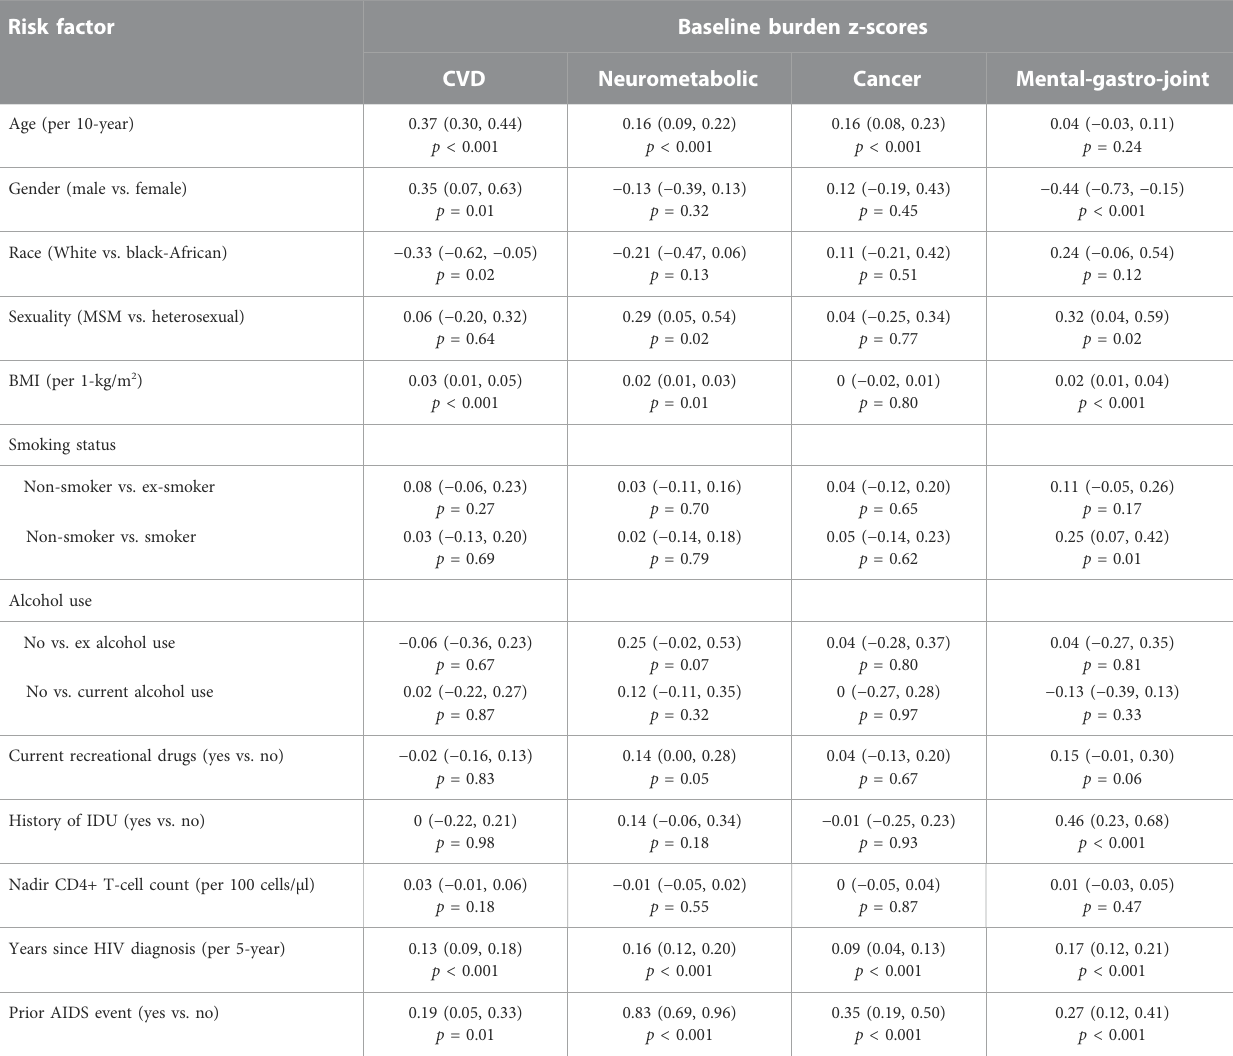
TABLE 3 The relative contributions of demographic, lifestyle and clinical factors to the burden of multimorbidity patterns at baseline ( n = 788) assessed using multivariable linear regression models, with regression coef fi cients (95% con fi dence intervals) and associated p -value reported. Risk